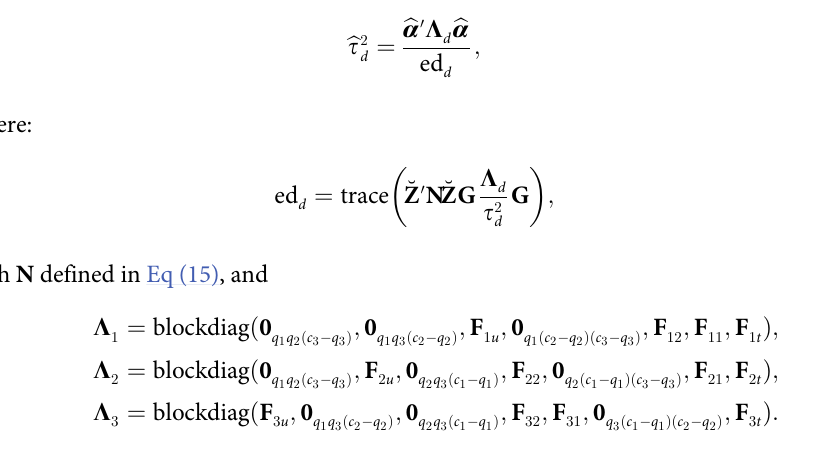
Algorithm 1 SAP algorithm for the ST-PCLM parameters